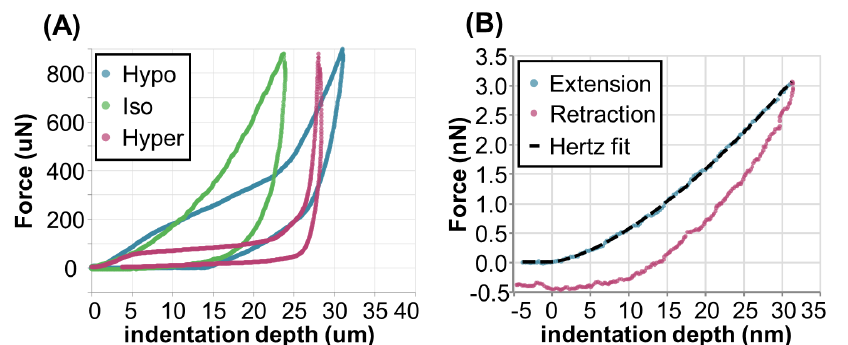
Figure A6. Stiffness comparison for each component of spring models.